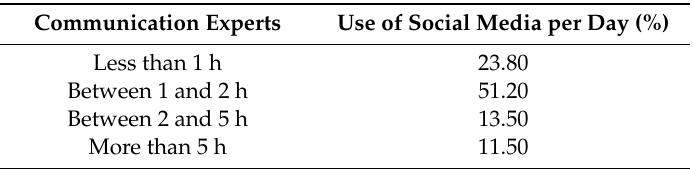
Table 4. Use of social media per day (%).